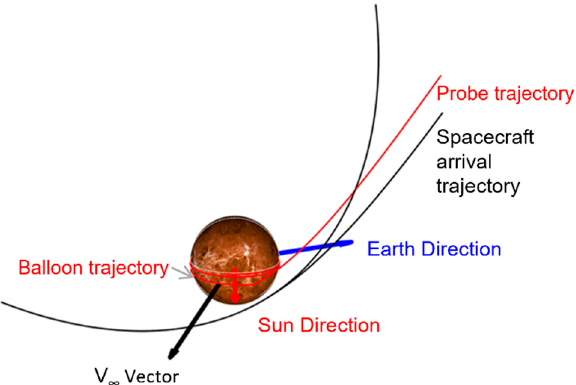
Figure 2. Arrival geometry of probe and orbiter. The arriving spacecraft on a trajectory to enter the atmosphere. The orbiter releases the probe 30 days before entering the atmosphere and performs a deflection maneuver to raise the altitude above the atmosphere.